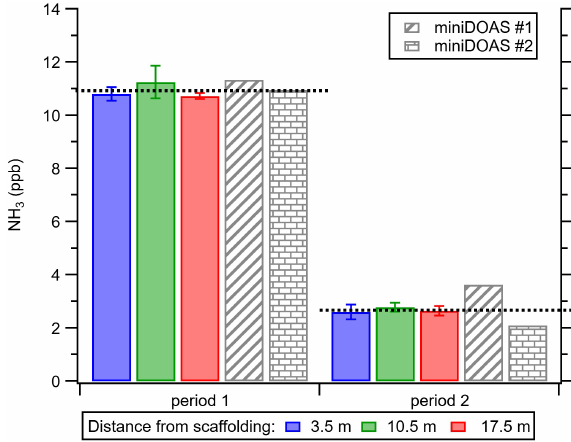
Figure 4. Average concentrations along the path length of the miniDOAS instruments, measured by passive diffusive samplers (ALPHAs) in triplicate at increasing distances from scaffolding. Error bars are ± σ A of the replicates at each position. (Period 1: 22 August 2016, 16:35, to 29 August 2016, 16:29; and Period 2: 29 August 2016, 16:29, to 5 September 2016, 17:42). Black dashed lines are the overall average concentration measured by the ALPHA samplers for the period. Data capture for Period 1 is summarised in Table S2. Data capture for Period 2: miniDOAS #1 = 89% and miniDOAS #2 =